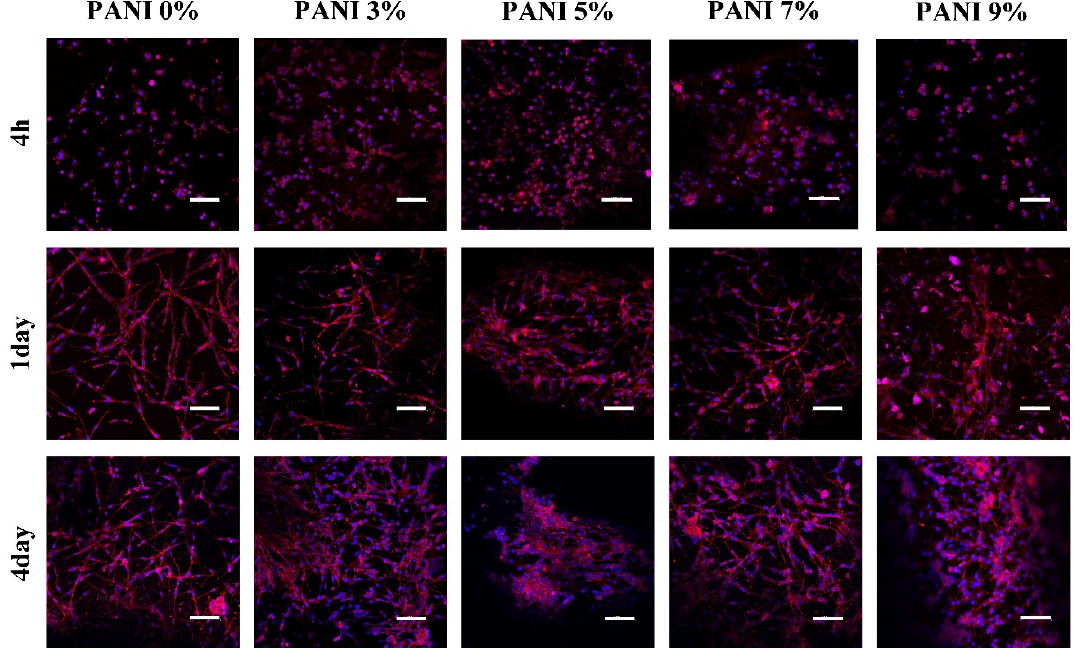
Figure 7. Surface morphology of U87 cells on bio-conductive materials with different concentrations of polyaniline (The white bar represents 100 μ m).